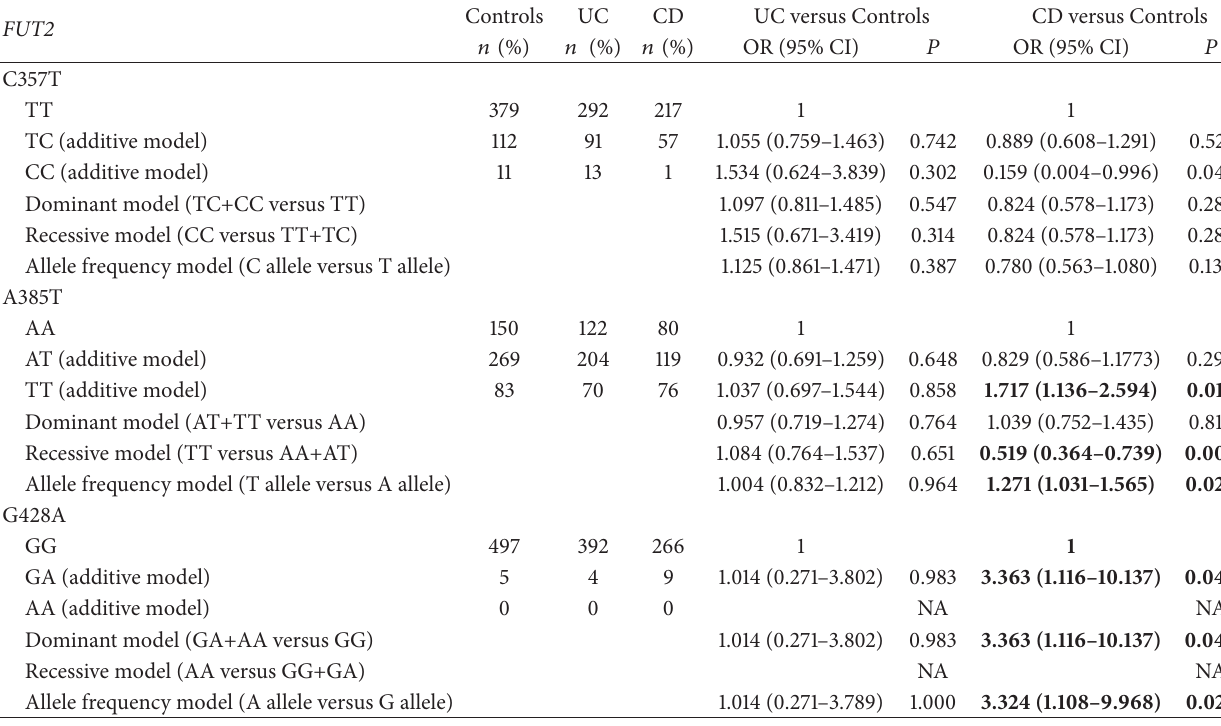
Table 2: FUT2 gene polymorphisms in patients with inflammatory bowel disease (IBD) and the controls. FUT2